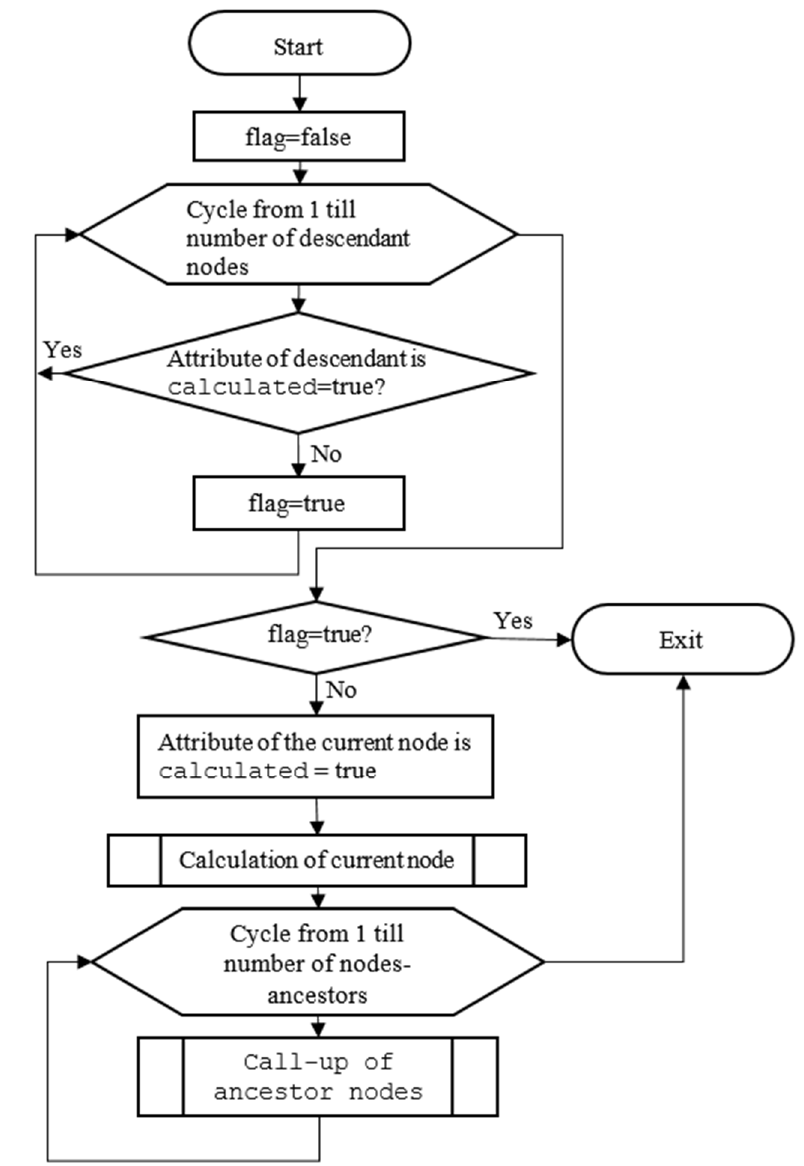
Figure 8. Algorithm of forward graph traversal.